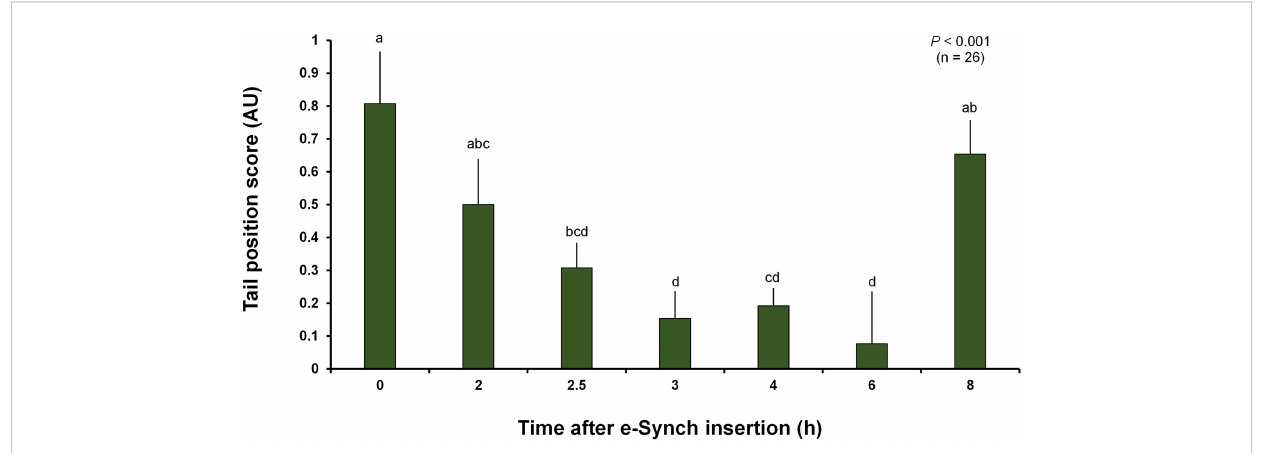
FIGURE 6 Tail position score from 0 to 8 h after e-Synch device insertion for cows in experiment